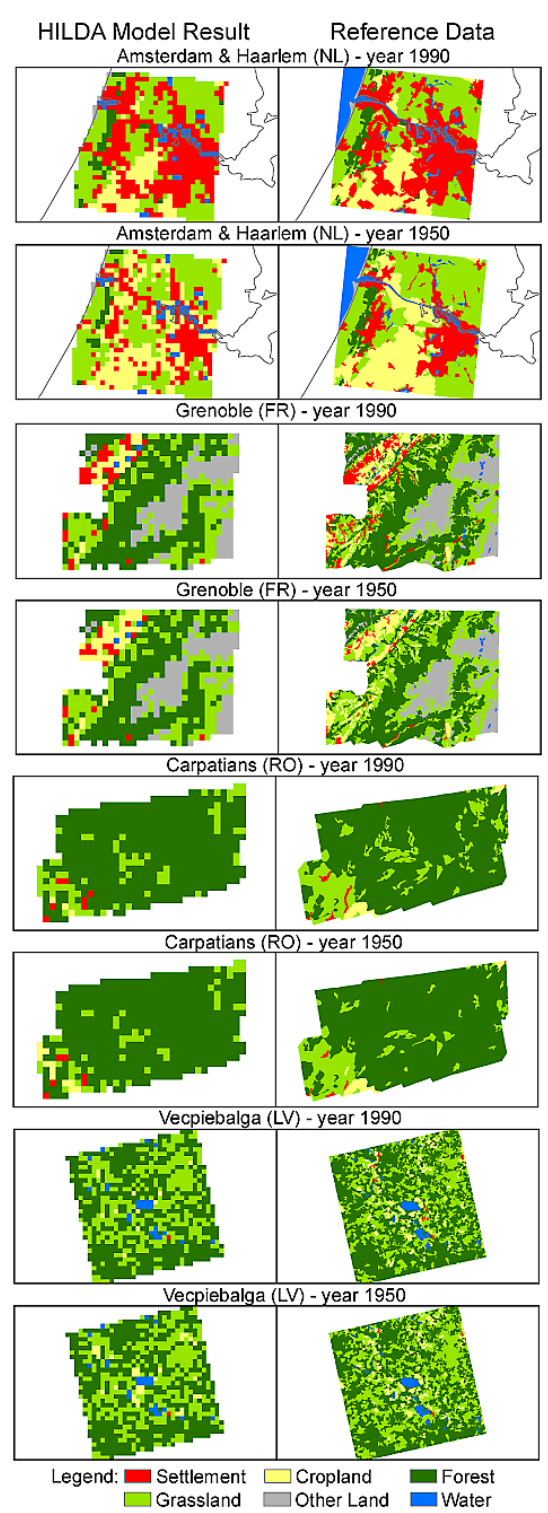
Fig. 9. Model validation (left) for four regional case studies with reference test sites (right), each for the years 1950 and